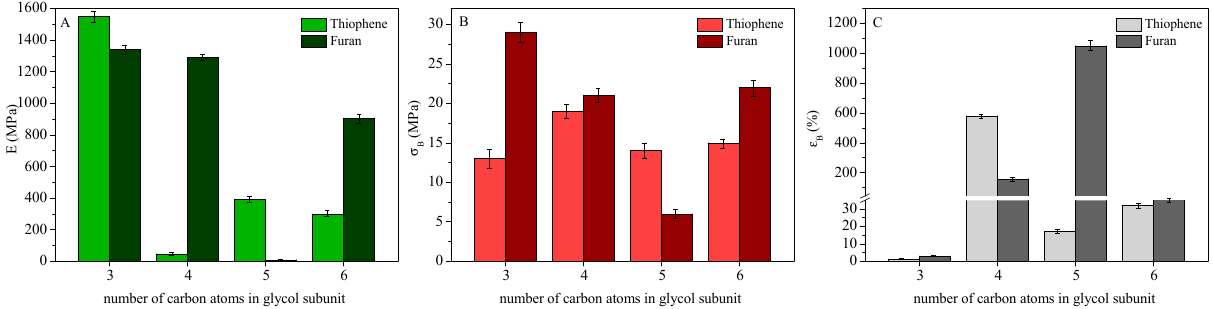
Figure 8. Comparison between mechanical characterisation data of thiophene-based homopolymers and their furan-based counterparts: ( A ) elastic modulus; ( B ) stress at break; ( C ) elongation at break.